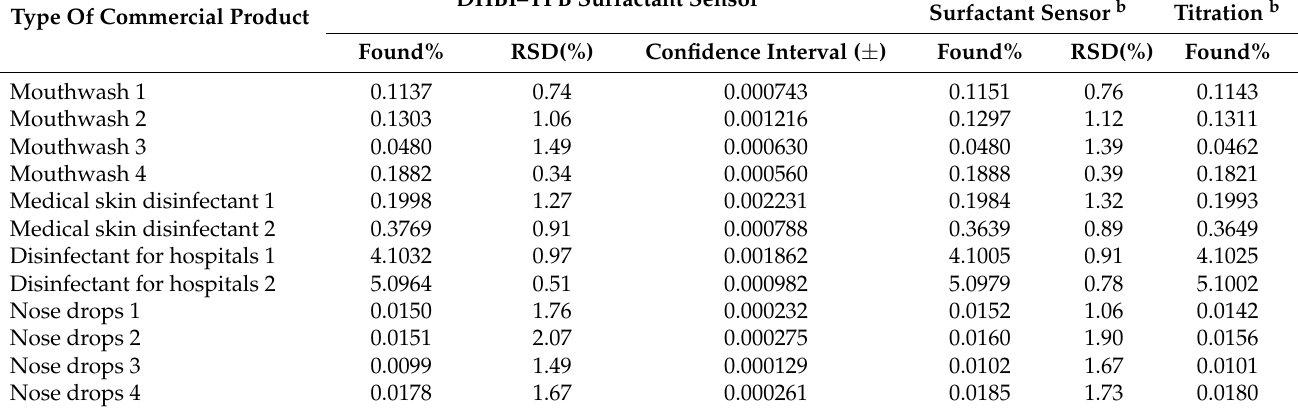
Table 5. The results of direct potentiometric titrations of twelve commercially available disinfectants and personal care products containing cationic surfactants using the TPB (5 × 10 − 3 M) as a titrant and DHBI–TPB surfactant sensor as the end-point indicator. The results were compared with the results obtained from the commercial surfactant sensor and a referent two-phase titration